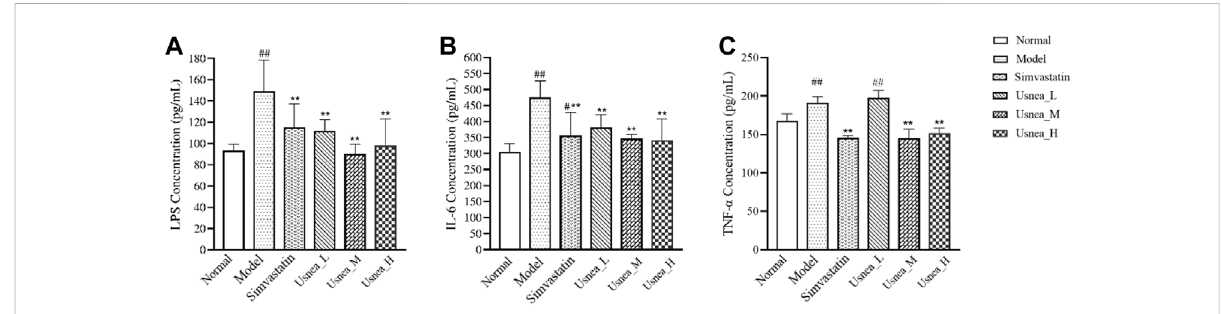
FIGURE 6 UEE affected the concentrations of LPS, IL-6, and TNF- α in the serum. (A) UEE decreased the concentration of LPS; (B) UEE inhibited the expression of IL-6; (C) UEE decreased the concentration of TNF- α . Results are expressed as the mean ± SD ( n = 6 per group). Compared with the normal group, # p < 0.05, ## p < 0.01; compared with the model group * p < 0.05, ** p < 0.01.